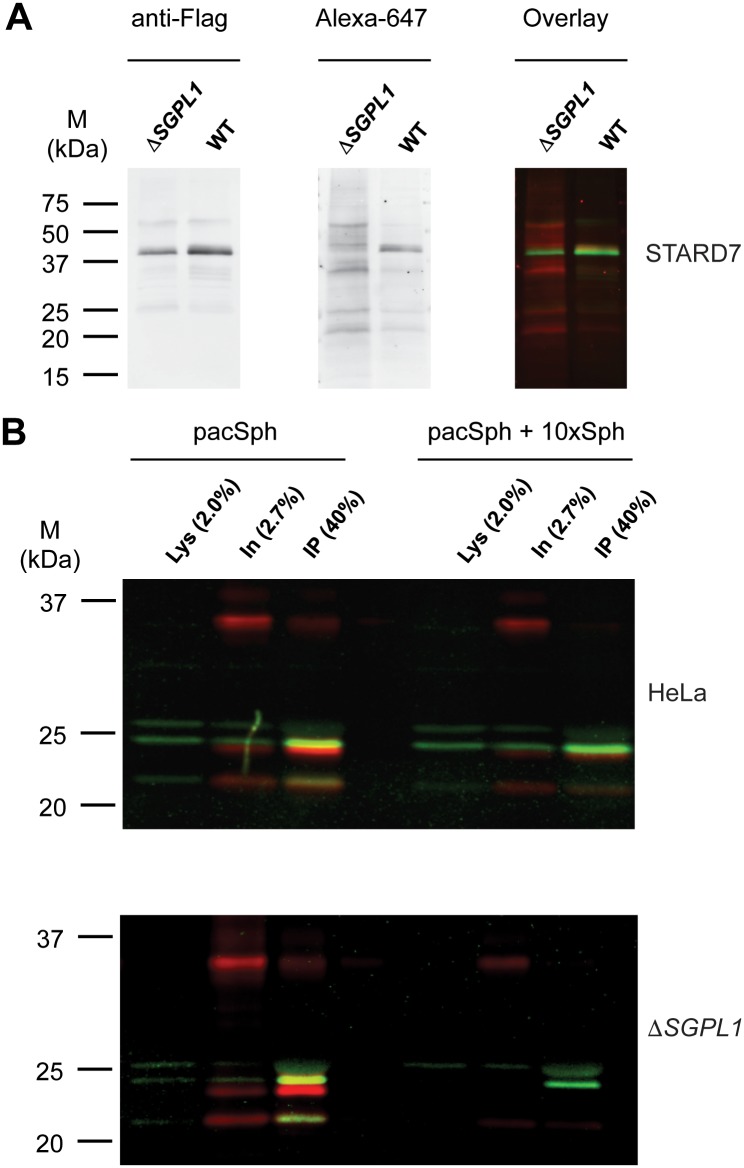
Fluorescent labeling of pacSph metabolites to study protein lipid interaction.Flag-tagged STARD7 (A) and p24 (B) were expressed in HeLa and HeLa ΔSGPL1 cell lines. Cells were metabolic labeled with 5 μM pacSph (STARD7) or 0.5 μM pacSph with or without sphingosine (p24) for 7 h and then UV irradiated to cross-link pacSph metabolites to nearby protein. Protein lysates were subjected to click reaction with Alexa647 azide (shown in red) and the ectopically expressed proteins were immunoprecipitated. After SDS-PAGE and immunoblot with fluorescently labeled secondary antibodies (shown in green), lipid and protein signals were detected in separate channels. Lys, Lysate, IN, input of immunoprecipitation, IP, immunoprecipitated material.